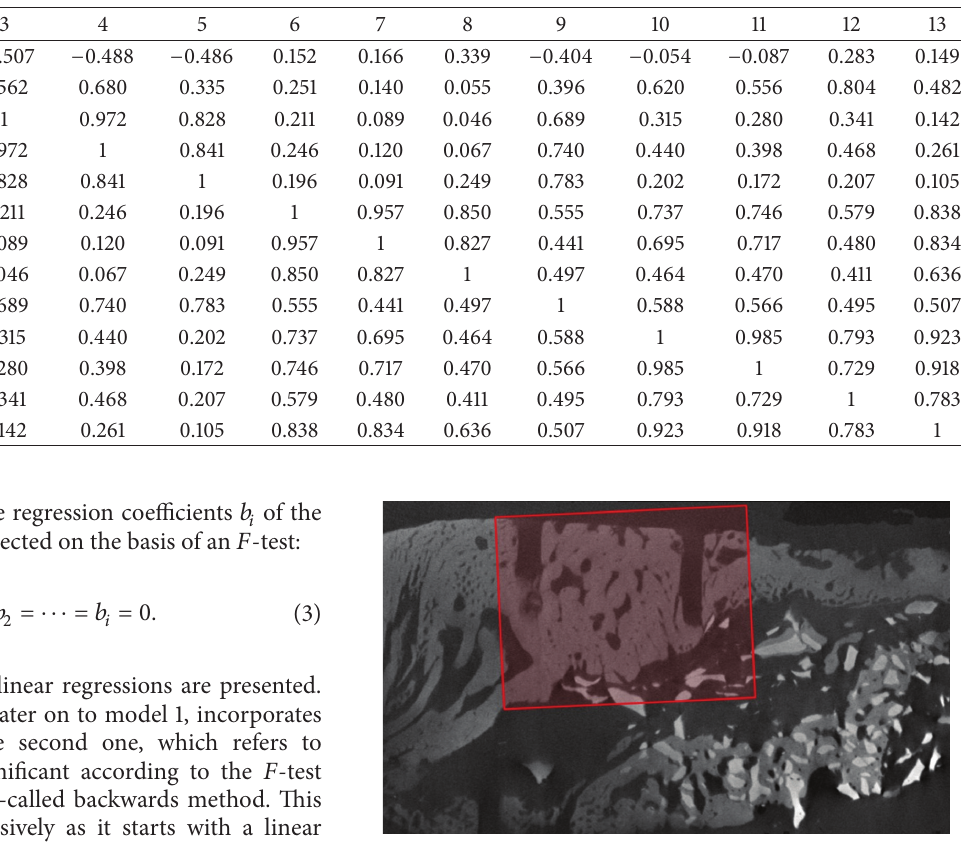
Figure 1: The appropriate region of interest related to the 𝜇 -CT